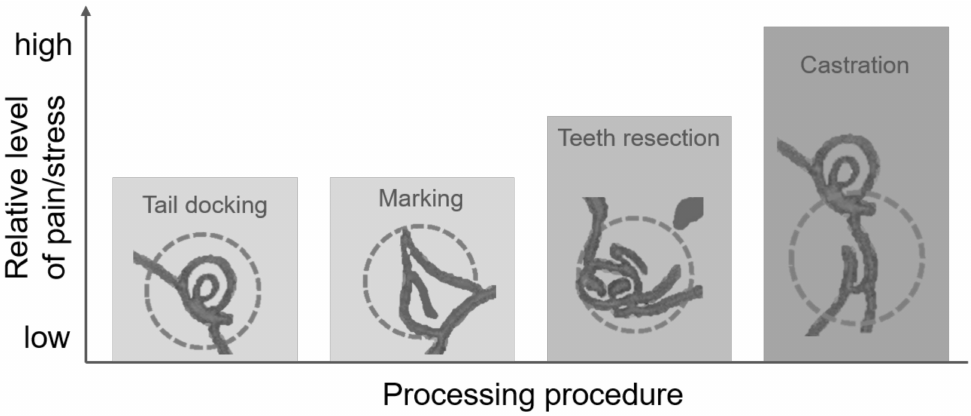
Figure 5. Relative pain and stress levels associated with four routine processing procedures: tail docking, marking for identification, teeth resection, and